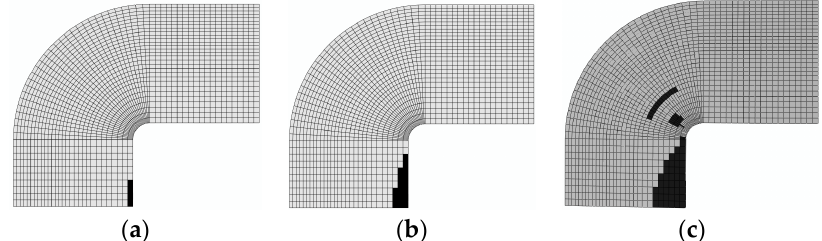
Figure 10. Fracture damage of repaired fiber ( − 90°): ( a ) 120 kN; ( b ) 143 kN; and ( c ) 213.1 kN.